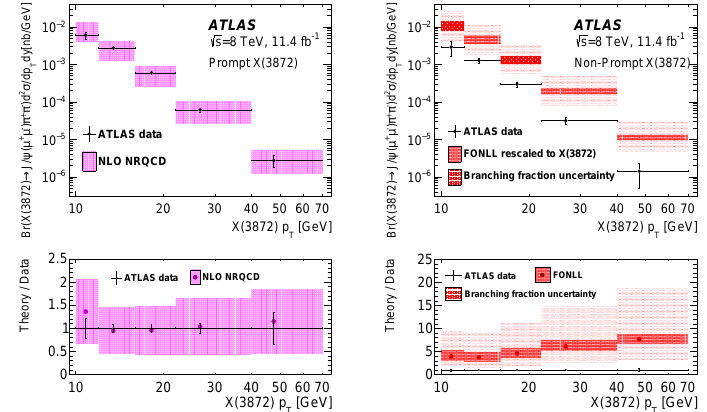
Figure 8. Measured cross-section times branching fraction as a function of p T for (left) prompt and (right) non-prompt X (3872) compared to theoretical expectations. Figures are taken from Ref.